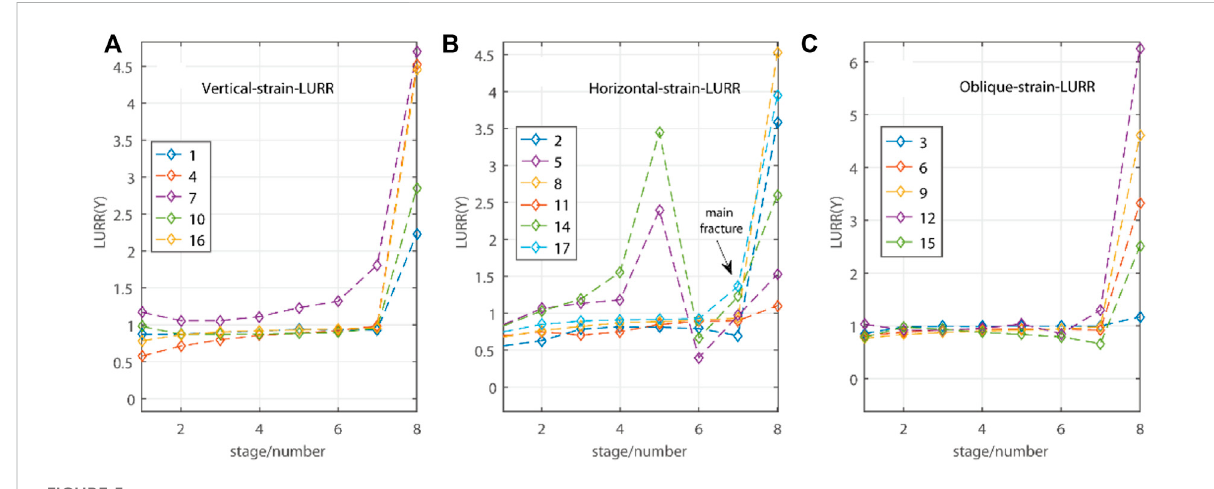
FIGURE 5 Load unload response ratio of strain energy in three directions (A – C) .